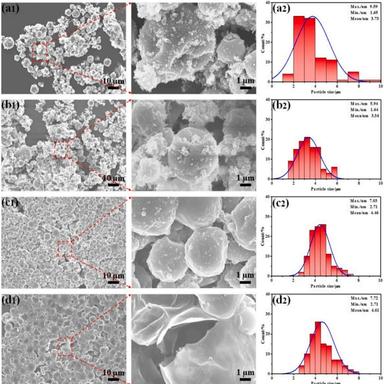
FE-SEM images and particle size distribution of MicroPCMs with different BS/HMDI/CS mass ratios: (a) 6.25:11.5:1, (b) 12.5:11.5:1, (c) 25:11.5:1 and (d) 37.5:11.5:1.